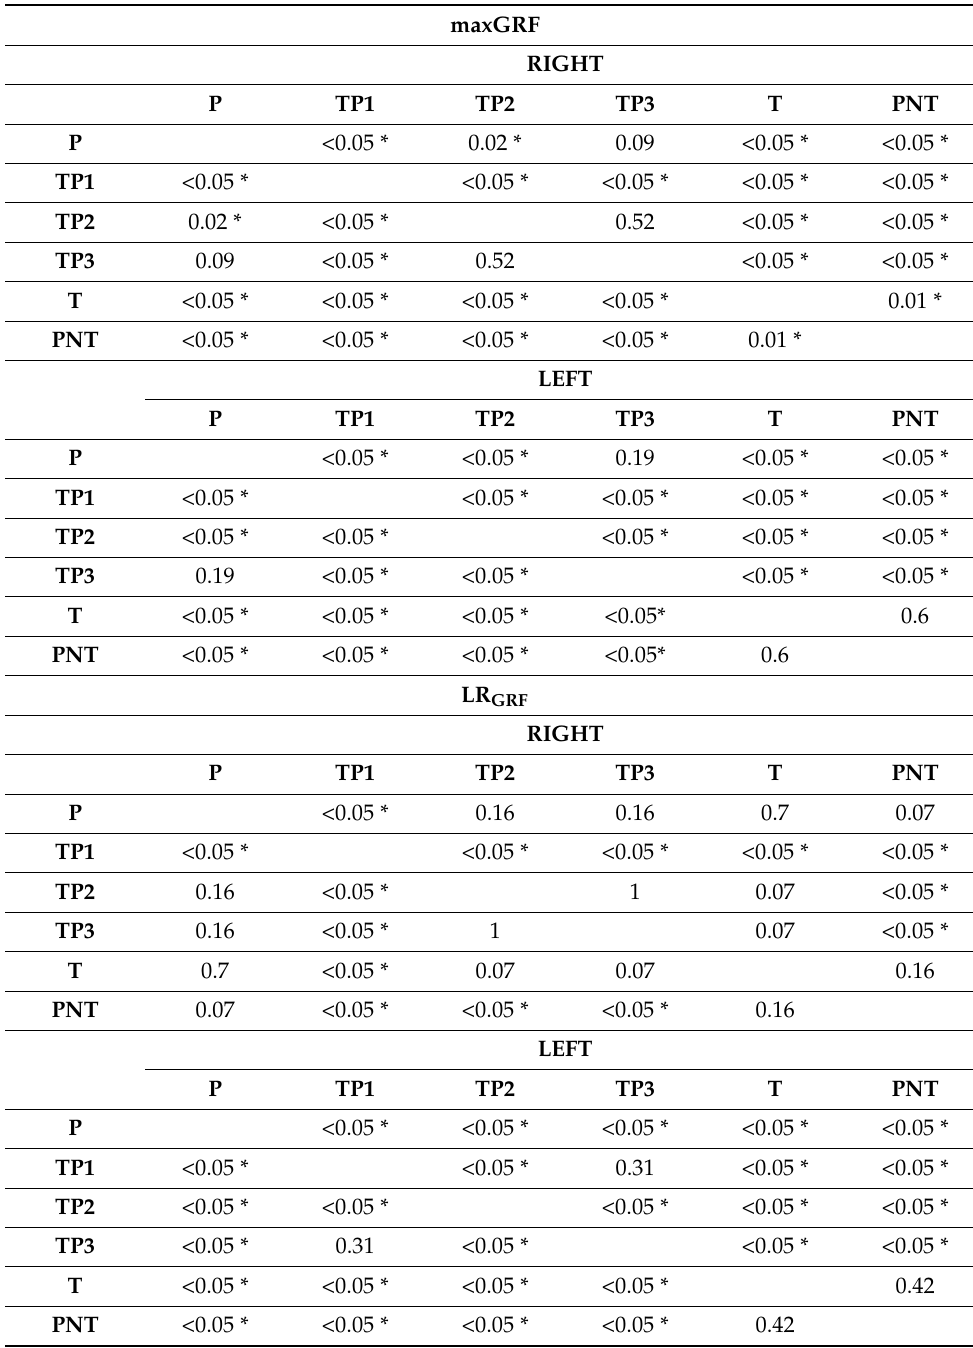
Table 2. Conover–Iman post-hoc test results for maxGRF and LR GRF for subsequent foot strikes in the ZAP3